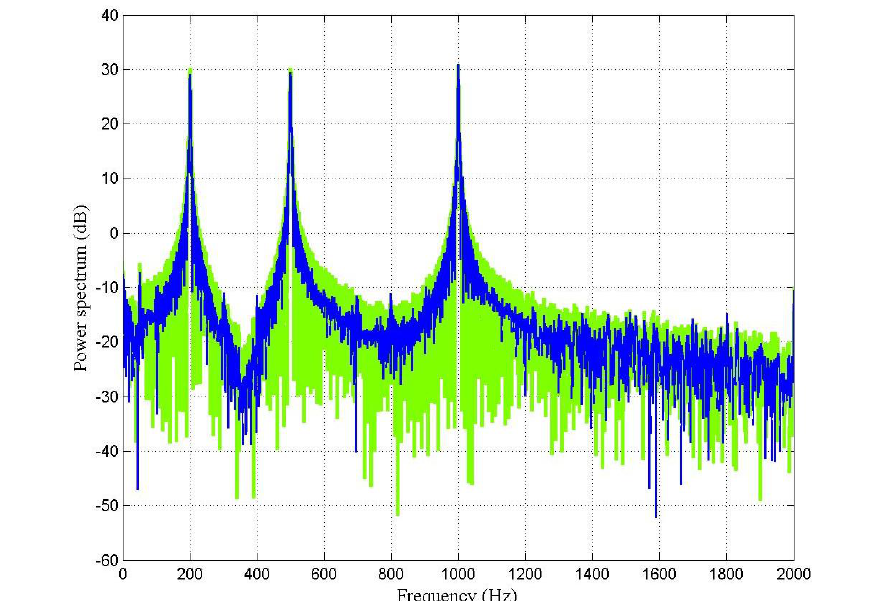
Figure 9. Power spectrum (dB) of the output signal before (green) and after (blue) filtering by using the fast LMS adaptive filter.